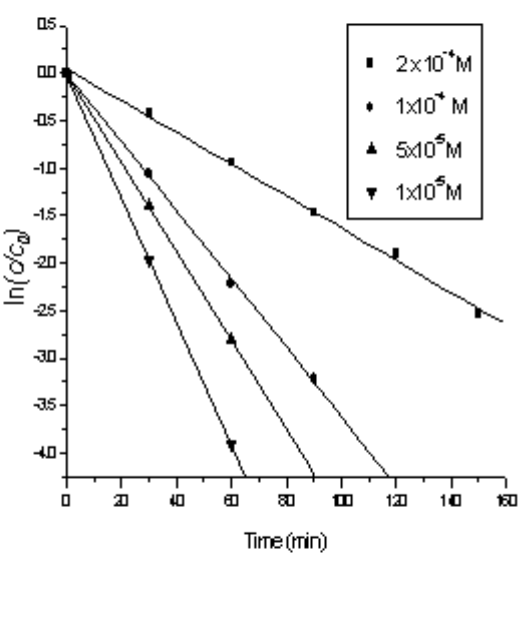
Fig. 3 The first order regression of the reaction at different initial